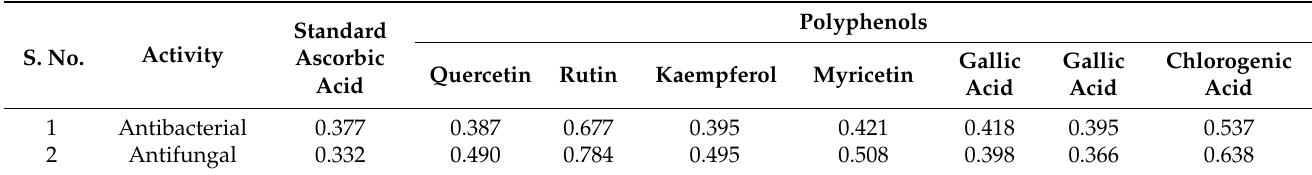
Table 4. Probability of activity (Pa) summary for the flavonoids and phenolic